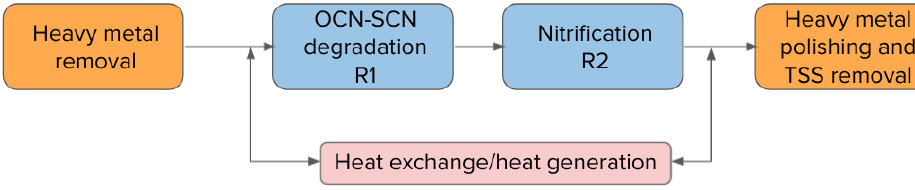
Figure 4. Full-scale plant process schematic.